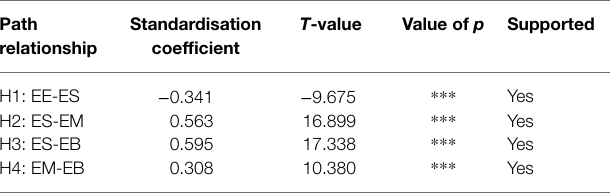
TABLE 5 | Analysis of the research